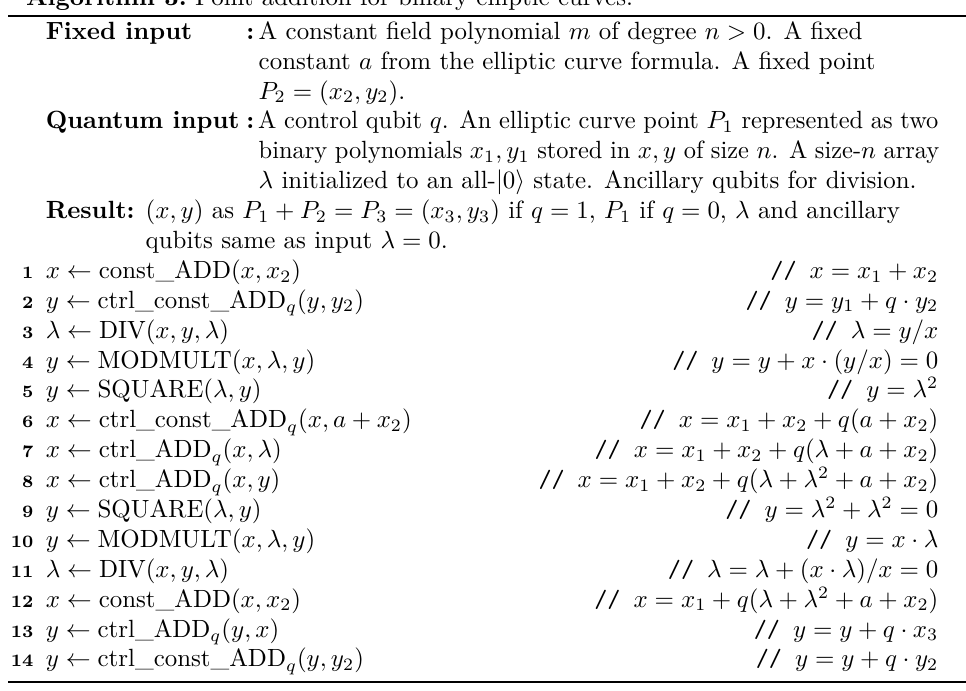
Algorithm 3: Point addition for binary elliptic